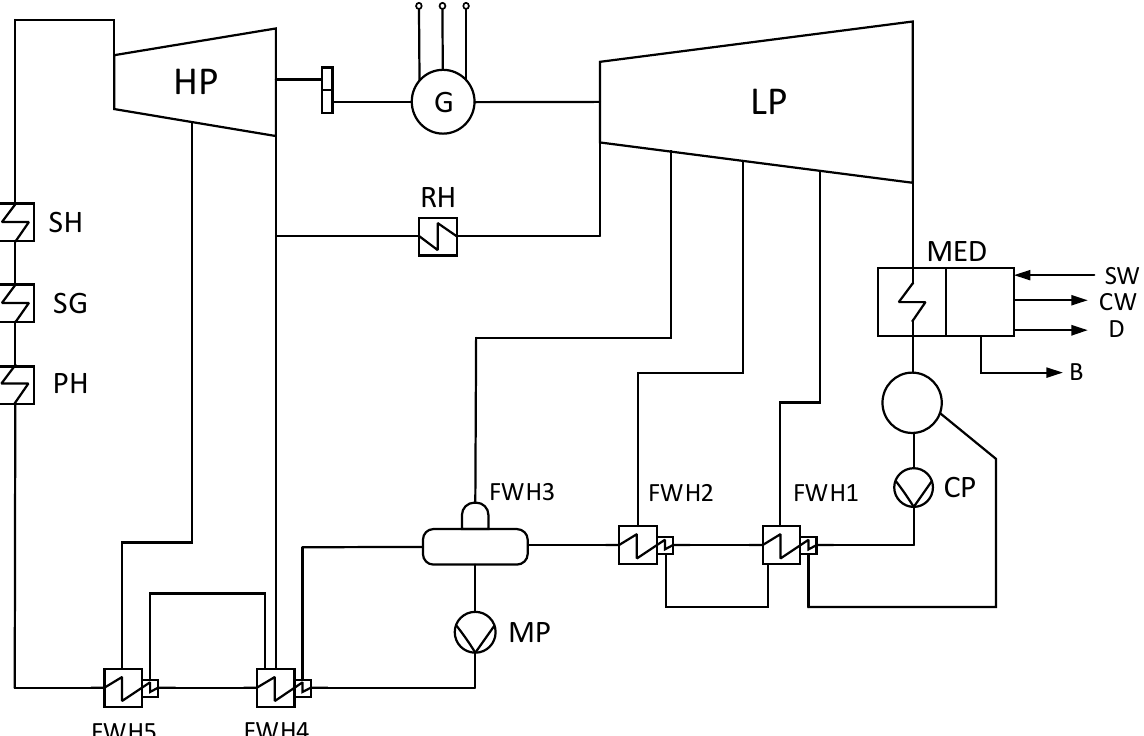
Figure 2. Power block scheme with the MED acting as the condenser of the cycle. PH = preheater; SG = steam generator; SH = superheater; HP = high-pressure turbine; G = electric generator; RH = reheater; LP = low-pressure turbine; CP = condensate pump; MP = main pump; FWH = feed water heater; SW = seawater; CW = cooling water; D = distillate; B = brine.